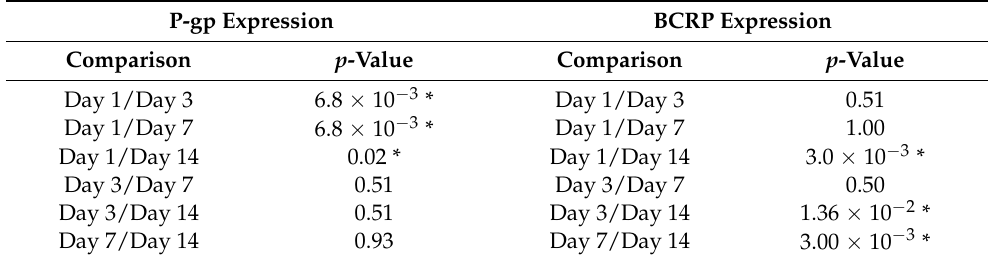
Table 2. p -values from P-gp and BCRP expression comparisons in 18 sonicated ROIs at all time points. p -values were corrected for multiple comparisons (fdr, alpha = 0.05). Corrected p-values less than 0.05 are flagged with one star